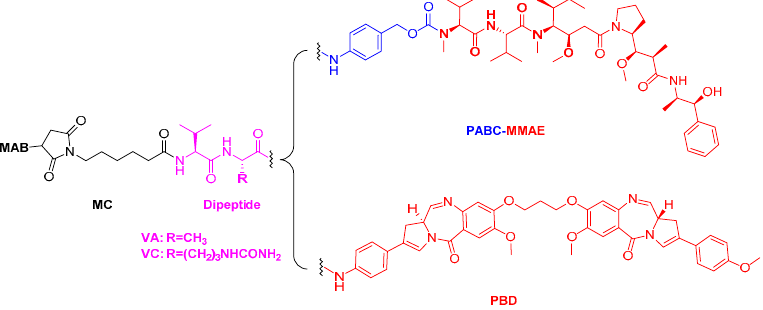
Figure 1. Structure models of the antibody-drug conjugates (ADCs): MAB-MC-VC-PABC-MMAE and MAB-MC-VA-PBD. MAB: monoclonal antibody; MC: maleimidocaproyl; VC: valine-citrulline; VA: valine-alanine; PABC: p-aminobenzylcarbamate; PBD: pyrrolobenzodiazepine; MMAE: monomethyl auristatin E.